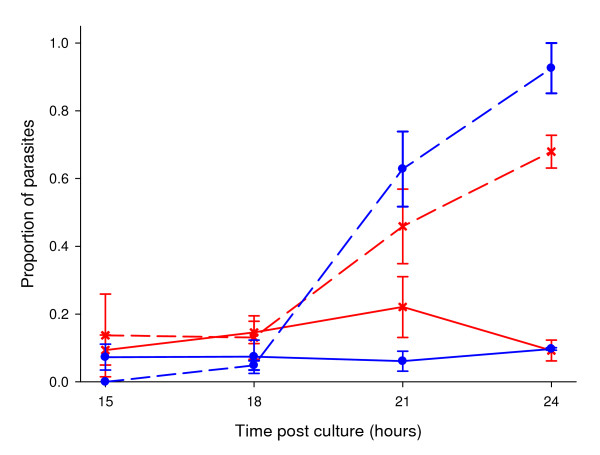
Markers for apoptosis vary over time and between species. Graphs show the proportion of ookinete stage parasites displaying DNA fragmentation as measured by TUNEL (solid lines) and Caspase-like activity (dashed lines) as measured by CaspaTag™ Pan-Caspase In Situ Assay Kit, Fluorescein in conjunction with propidium iodide (Chemicon international, USA) in Plasmodium berghei (red lines with crosses) and Plasmodium yoelii (blue lines with circles). Bars show standard errors of the mean and values are based on between 3 and 6 individual infections per time point. For each mouse 8 ookinete cultures were set up which were incubated for 14 hours before the cultures from each mouse were pooled and purified for ookinetes using macs ls cell separation columns (Miltenyi biotec). The resulting purified ookinetes were then alliquated into 8 individual 1 ml cultures (1 per time point for 2 assays) containing complete ookinete media. These cultures were then returned to the incubator until the time relevant time point (15, 18, 21 or 24 hours post culture set up). More detailed methodology is available in Additional file 1.